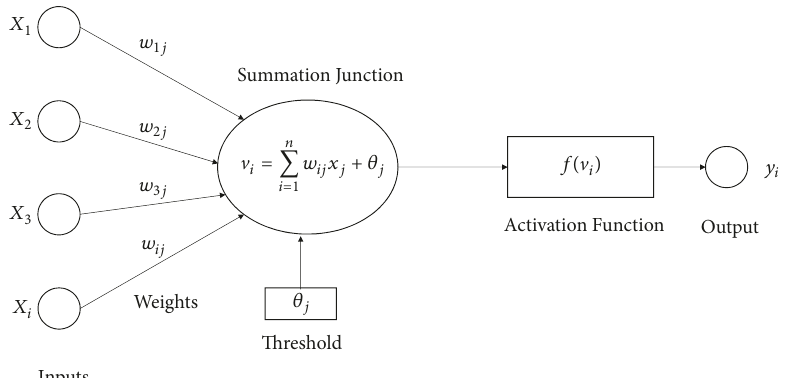
Figure 1: A model of single neuron.